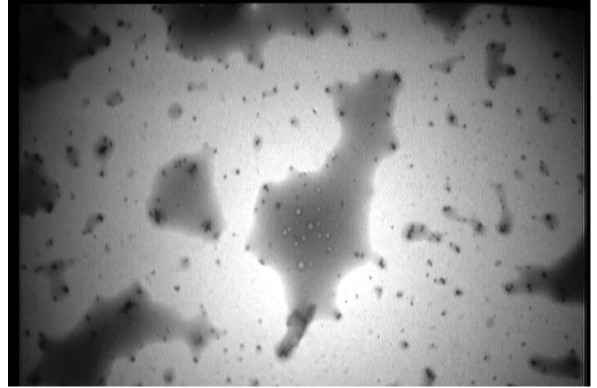
Figure 3 Transmission electron microscopy (TEM) micrograph recorded from a drop-coated film of an aqueous solution of Ag + ions incubated with freshly cultured S. boulardii (after 5 h biotransforma- tion). Magnification is: